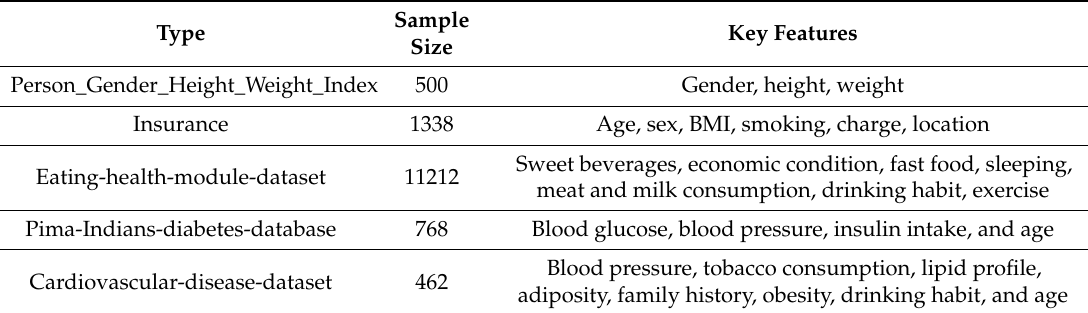
Table 4. Short description of the selected datasets.